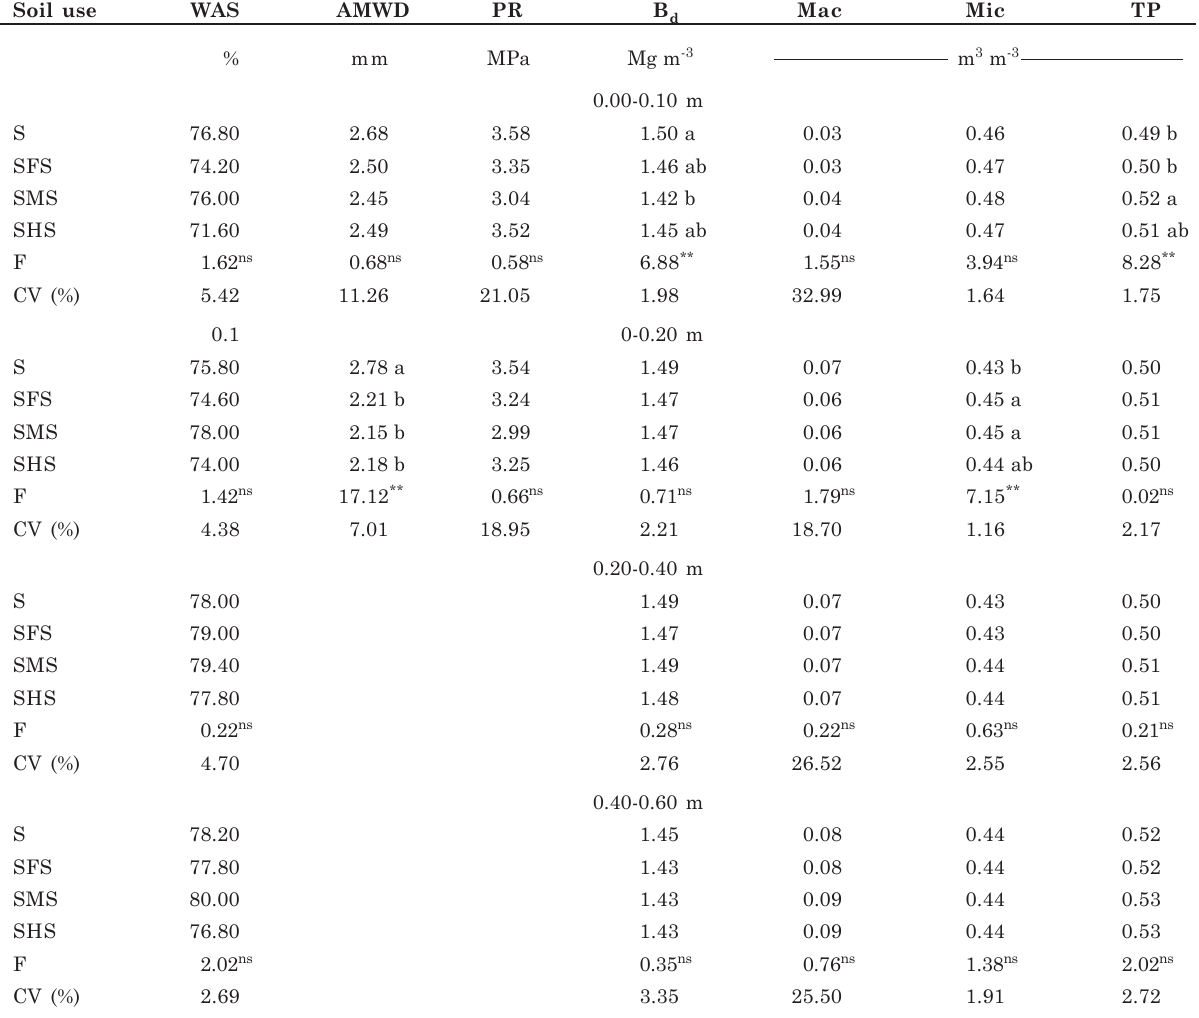
Table 3. Water stability of soil aggregates (WAS), aggregate mean weight diameter (AMWD),